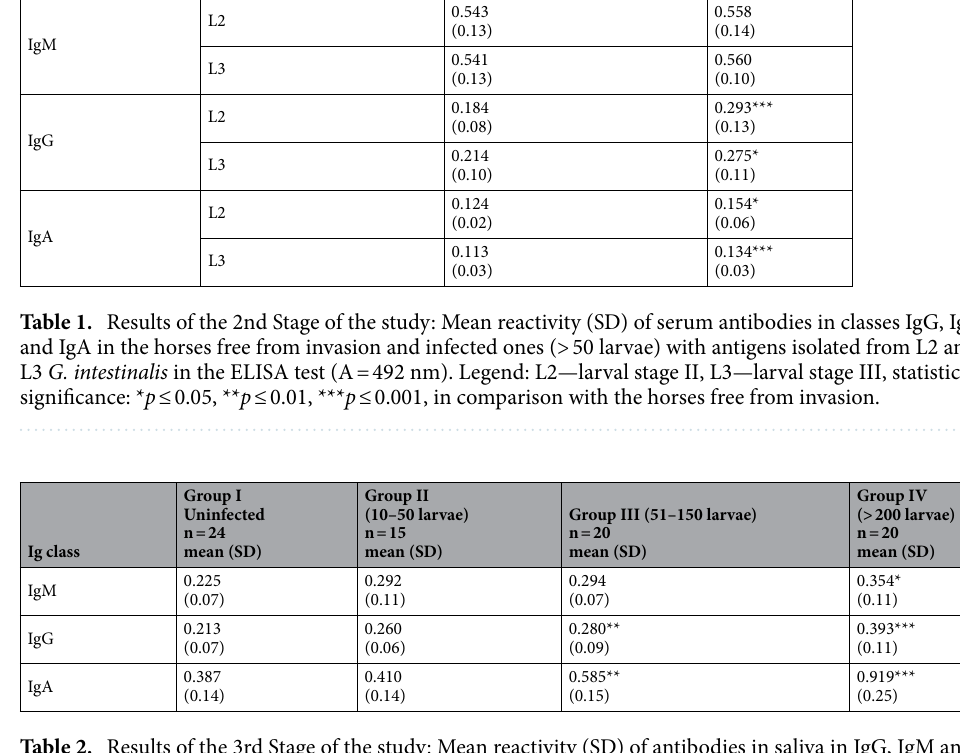
Table 2. Results of the 3rd Stage of the study: Mean reactivity (SD) of antibodies in saliva in IgG, IgM and IgA classes in horses free from invasion and manifesting diverse intensity of invasion u with antigens L3